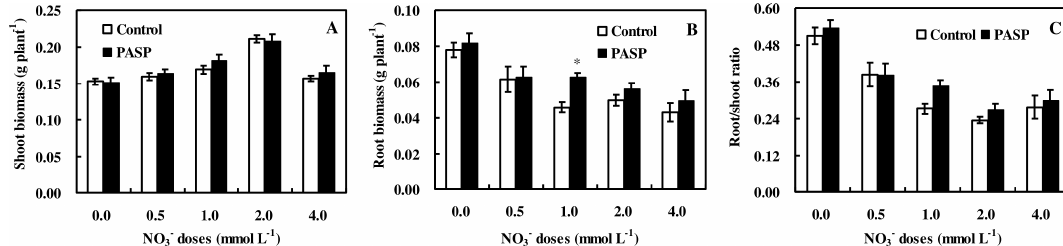
Figure 1. The biomass accumulation in the shoots ( A ) and roots ( B ), as well as the root/shoot ratio ( C ), of maize differed on the 7th day after nitrogen and polyaspartic acid (PASP) treatment. The PASP and control indicate seedlings with and without PASP addition, respectively. Data was presented as the mean ± standard error of 15 plants in each treatment. *, statistically significant differences between PASP treatment and control within each nitrogen level, according to Student’s test at p < 0.05.